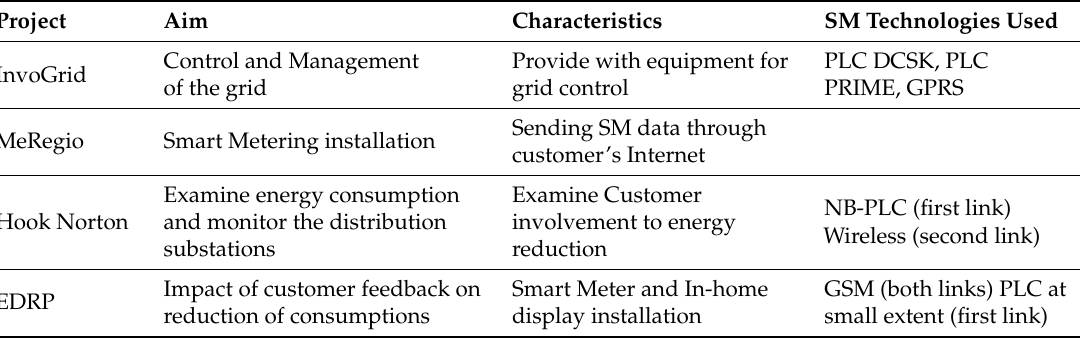
Table 3. Summary of Smart Metering Application projects and their main